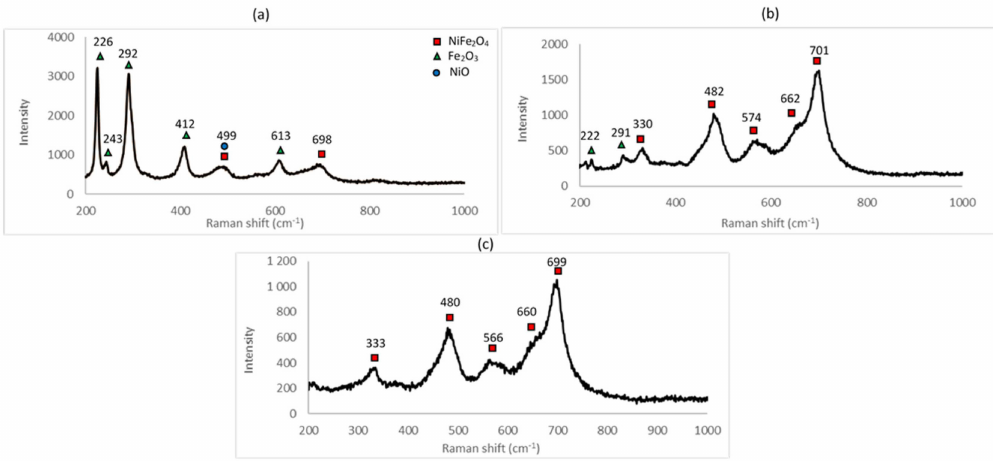
Figure 4. Raman spectrum of ( a ) sample A_1 (600 ◦ C for 48 h), ( b ) sample A_2 (800 ◦ C for 48 h) and ( c ) sample A_3 (1000 ◦ C for 48 h).